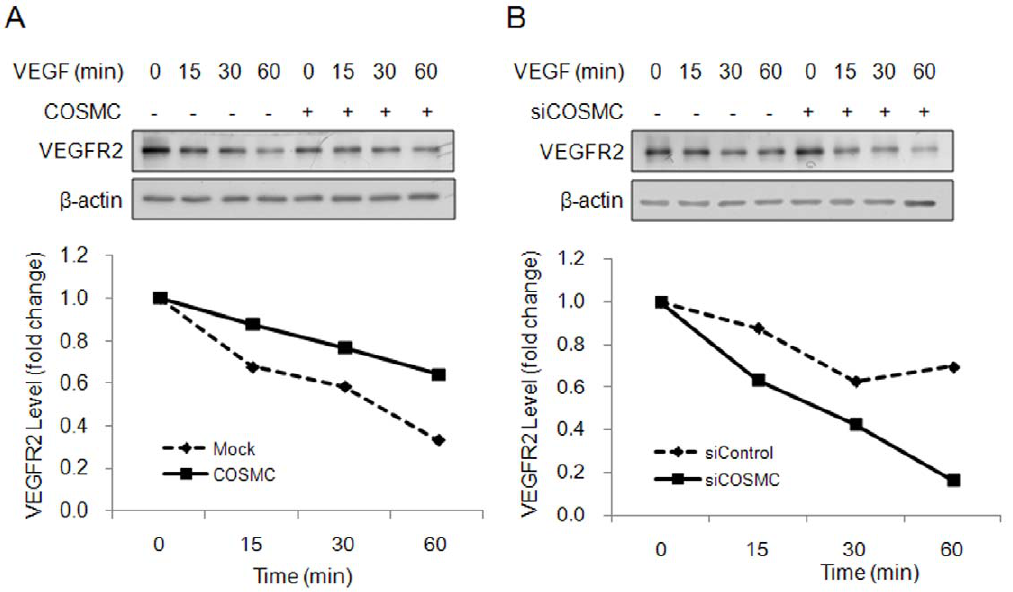
Figure 6. COSMC modulates protein degradation of VEGFR2. (A) COSMC overexpression delays degradation of VEGFR2. HUVECs were treated with cycloheximide (10 m g/ml) to block protein synthesis and 20 ng/ml of VEGF to trigger internalization and degradation of VEGFR2 for indicated time points. Upper panel shows representative Western blots. Lower panel shows signals on Western blots quantified by ImageQuant5.1 for HUVECs transfected with pcDNA3.1 control plasmid (dashed line) and UVECs transfected with COSMC/pcDNA3.1 (solid line). (B) COSMC knockdown facilitates degradation of VEGFR2. VEGFR2 degradation in HUVECs transfected with control siRNA (dashed line) or COSMC siRNA (solid line) was shown. Representative data from two independent experiments are